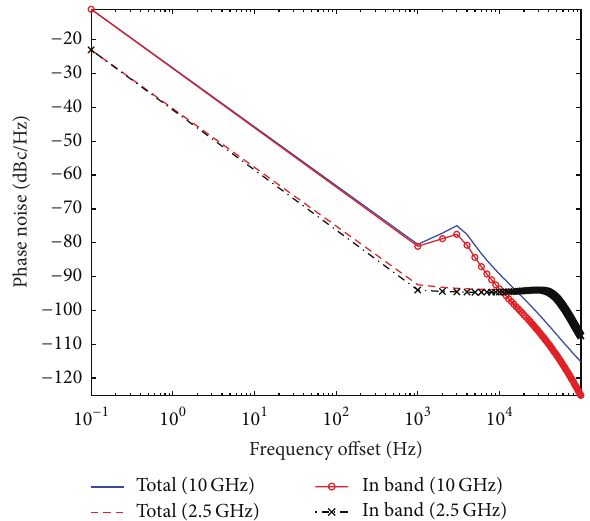
Figure 4: Prediction of frequency instability, ADEV: overlapping Allan standard deviations, TDEV: Allan time standard deviations.